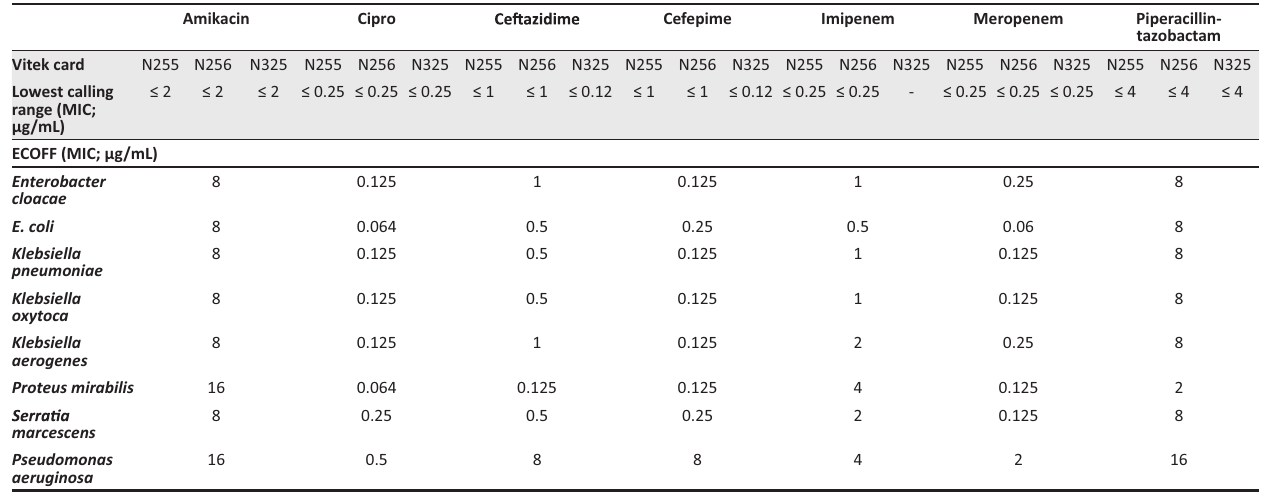
Amikacin Cipro Cefepime Imipenem